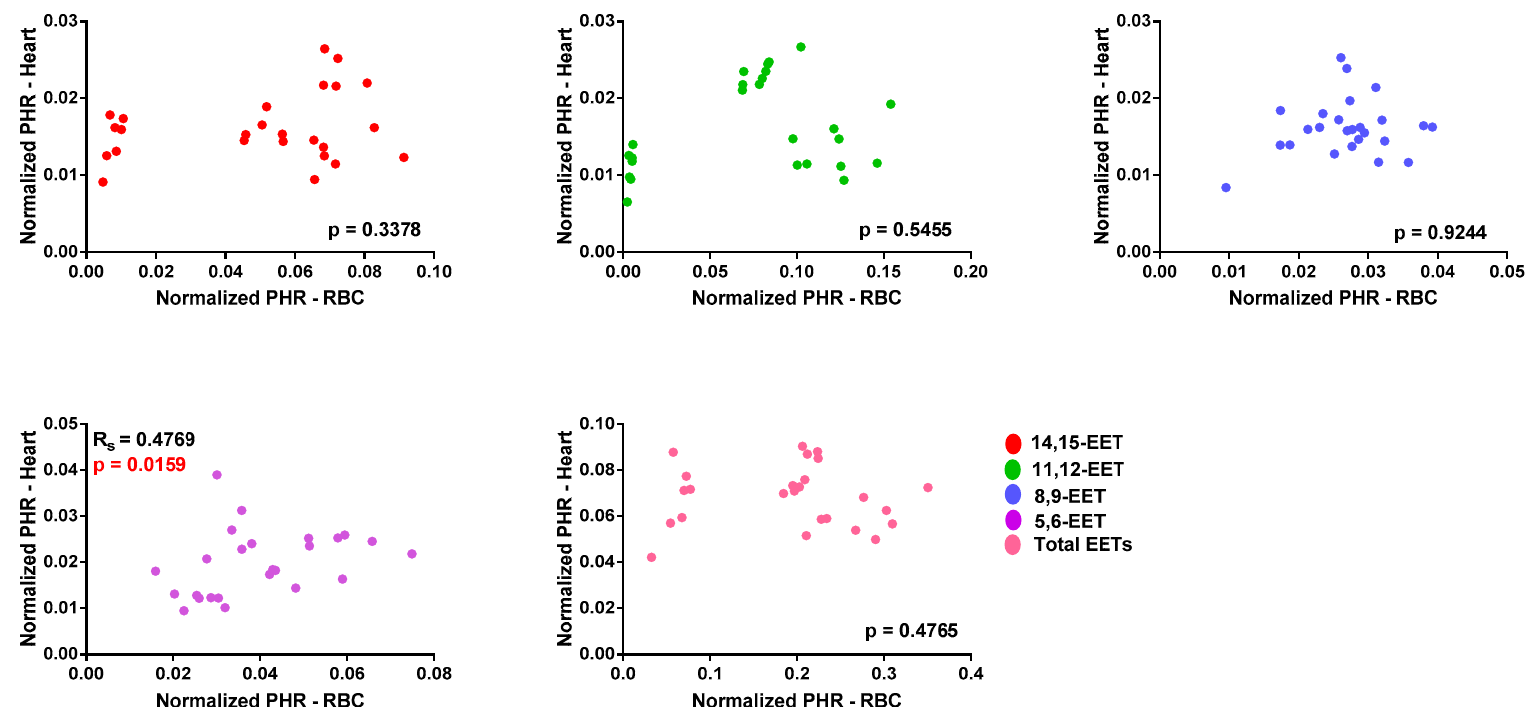
Figure 2. Correlation of each cis- epoxyeicosatrienoic acid (EET) regioisomer and total cis- EETs in erythrocyte membrane and cardiac tissue of wild-type mice. Relative amount of each regioisomer of EETs was represented by normalized peak height ratio (PHR) in erythrocyte membrane or cardiac tissue.